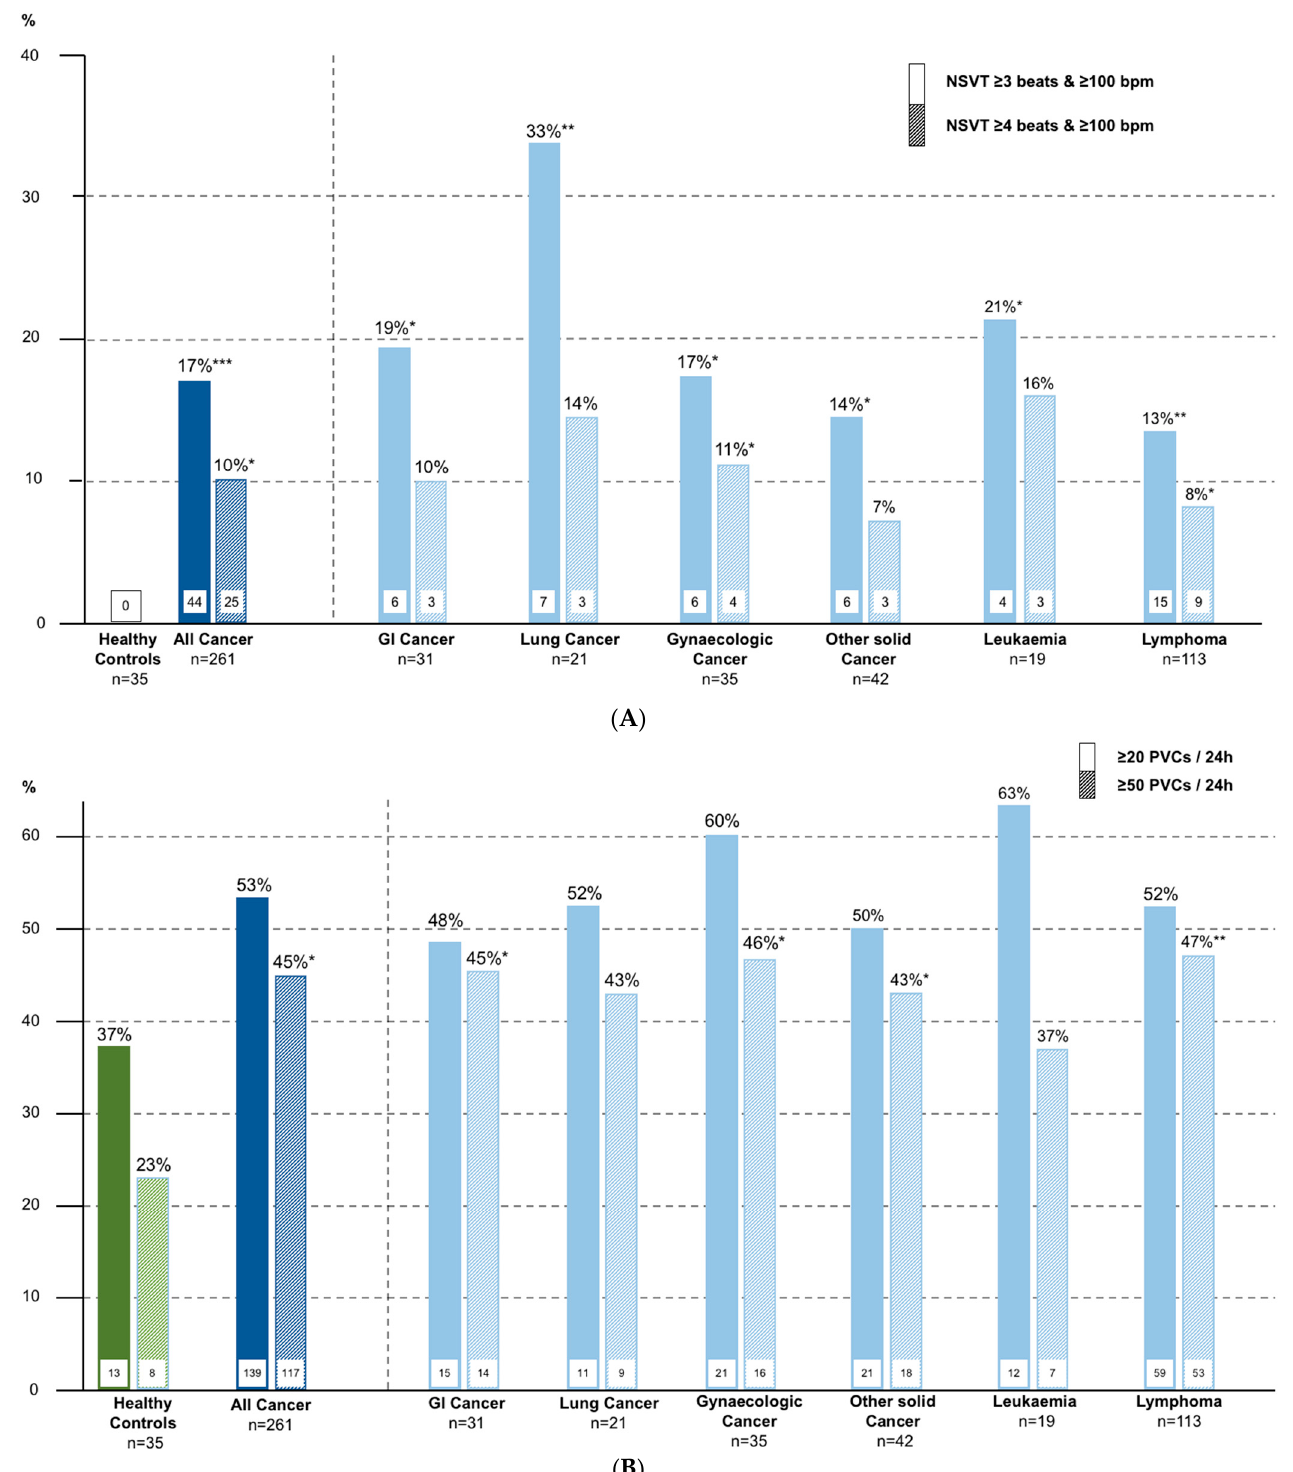
Figure 2. ( A ) Proportion of subjects with NSVT ≥ 3 beats & ≥ 4 beats. NSVT, non-sustained ventricular tachycardia; GI, gastrointestinal; bpm, beats per minute, * p < 0.05, ** p < 0.01, vs. healthy controls; ( B ) Proportion of subjects with ≥ 20 PVCs & ≥ 50 PVC/24 h. PVCs, premature ventricular contractions; GI, gastrointestinal; bpm, beats per minute, * p < 0.05, ** p < 0.01, vs. healthy controls.